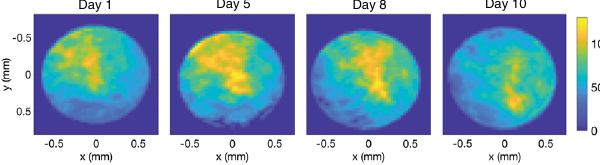
FIG. 5. Examples of single shot LCLS injector laser profiles over the course of 10 days. Camera intensity is in arbitrary units.